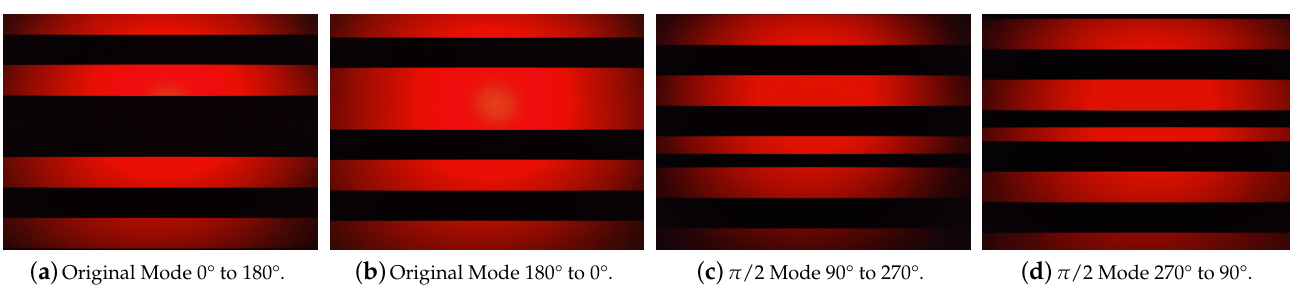
Figure 13. Phase shift visible in the stripe pattern to transmit a logical